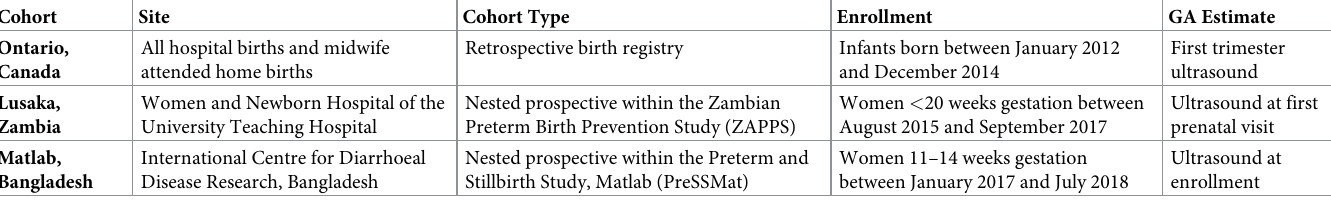
Table 1. Summary of Ontario, Zambia and Bangladesh